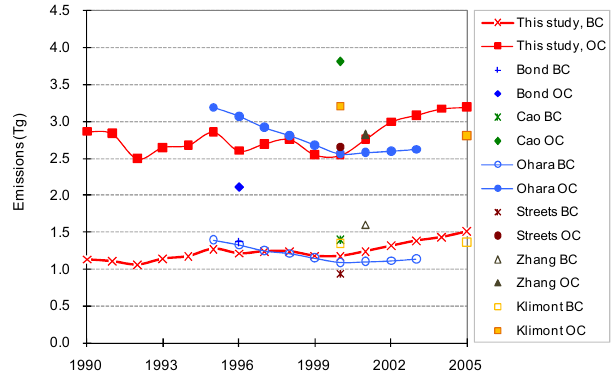
Fig. 14. Comparison of BC and OC emission estimation among recent studies: Bond et al., 2004; Cao et al., 2006; Klimont et